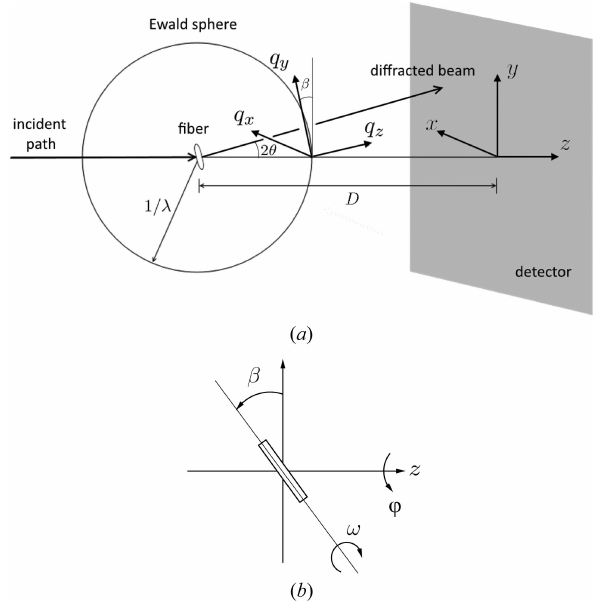
Figure 6 ( a ) Diffraction geometry for (cid:2) > 0, and ( b ) definition of the angles ð ’;(cid:2);! Þ for the orientation of the specimen, looking along the negative x